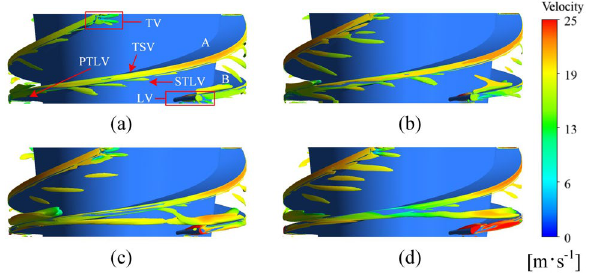
Figure 6. Flow pattern of the TLV. ( a ) 80 m 3 ∙h −1 , ( b ) 90 m 3 ∙h −1 , ( c ) 100 m 3 ∙h −1 , and ( d ) 110 m 3 ∙h −1 .